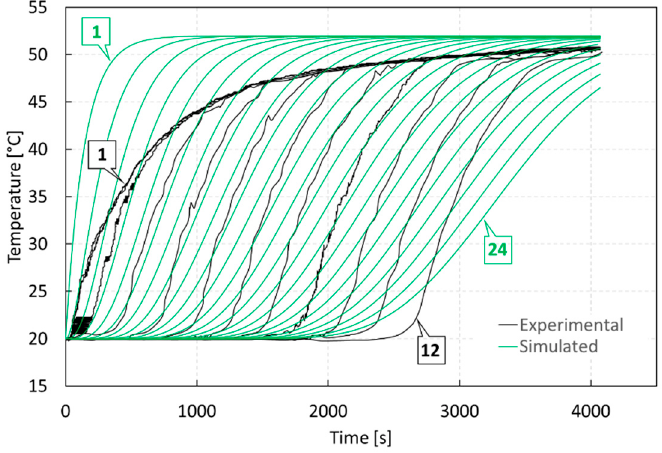
Figure 8. Temperature evolution during the charge phase—experimental vs. simulated (24 nodes).